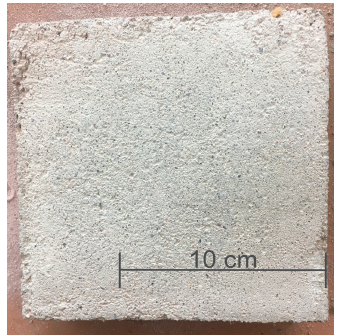
Figure 6. Exemplary optical view of the surface of the concrete substrate after grinding.